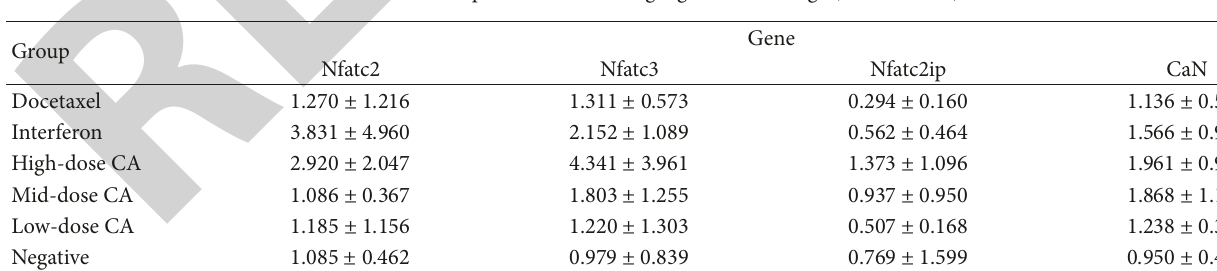
Table 6: Relative expression level of target genes on average ( 𝑥 ± 𝑠 , 𝑛 = 10